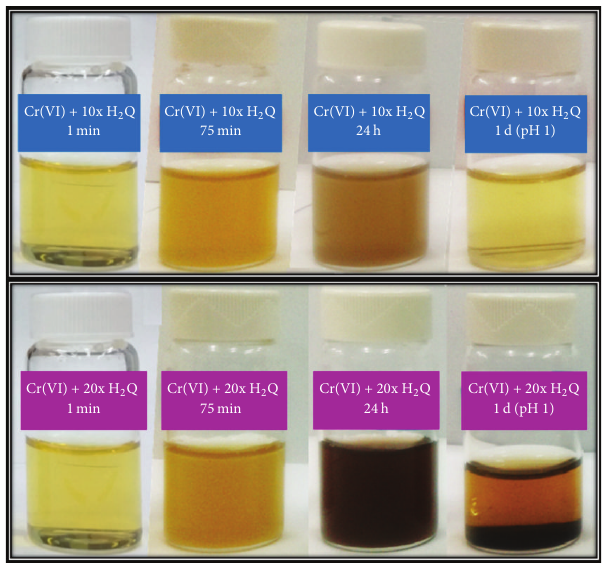
Figure 3: The changes in the solution colors of 105mg L −1 Cr(VI) reacting with 200 mg L −1 and 400 mgL −1 H 2 Q at pH 3.0 and 25 ∘ C, denoted as Cr(VI) + 10x H 2 Q and Cr(VI) + 20x H 2 Q, respectively, for 1 and 75 min and 24 h. 1 d (pH 1) indicated that the sample was obtained by mixing 200/400 mgL −1 H 2 Q and 105 mgL −1 Cr(VI) at pH 3.0 for 24 h, followed by the acidification treatment at pH 1.0 for 1d.